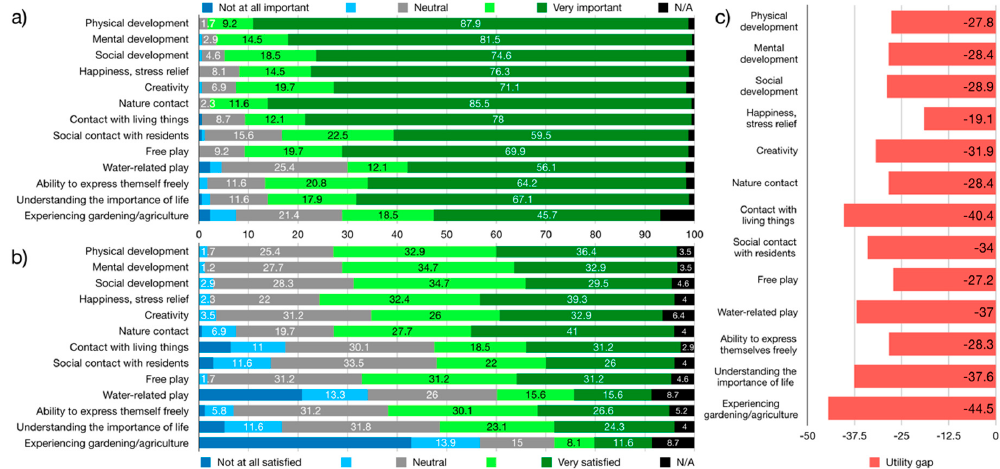
Figure 4. Caregivers perception of GS: ( a ) importance of outdoor play for children aged five or under in regard to…, ( b ) satisfaction with regularly used greenspace in regard to…, ( c ) utility gap between